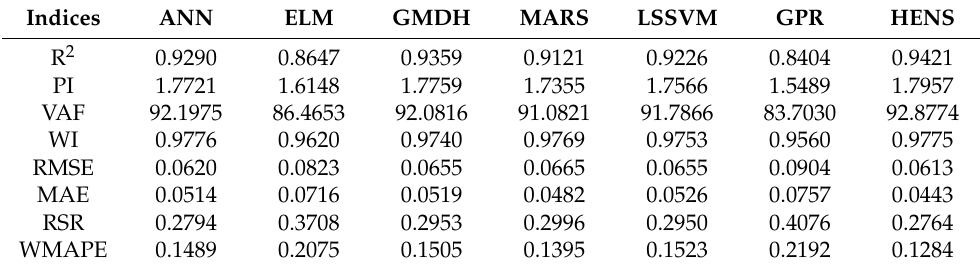
Table 4. Performance indices for the testing dataset.